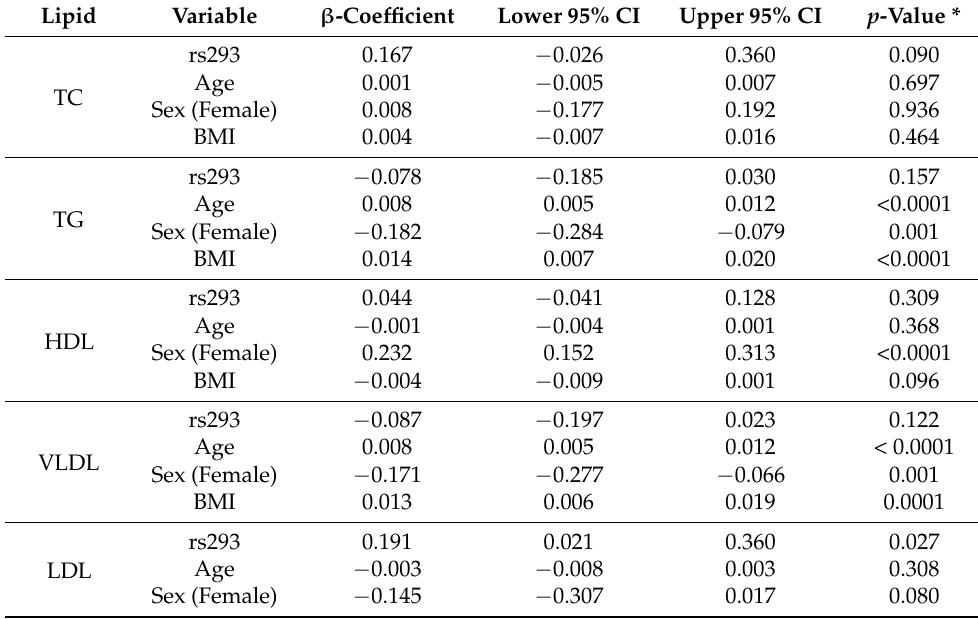
Table 5. A linear regression assessing the association between rs293 under a dominant genetic model with lipid levels adjusting for age, sex, and BMI in 466 Kuwaiti